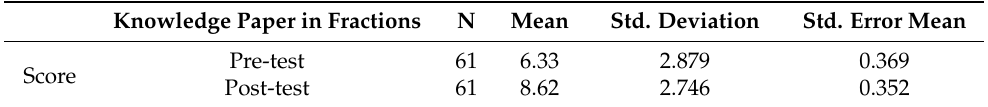
Table 6. Performance of C.G.—A.A.P.